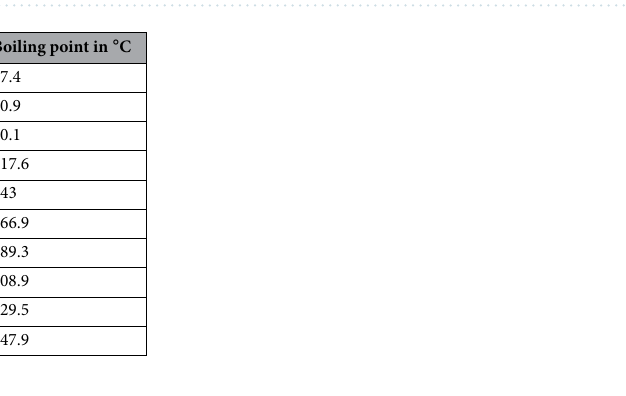
Figure 3. Shows the model fit and the residuals.